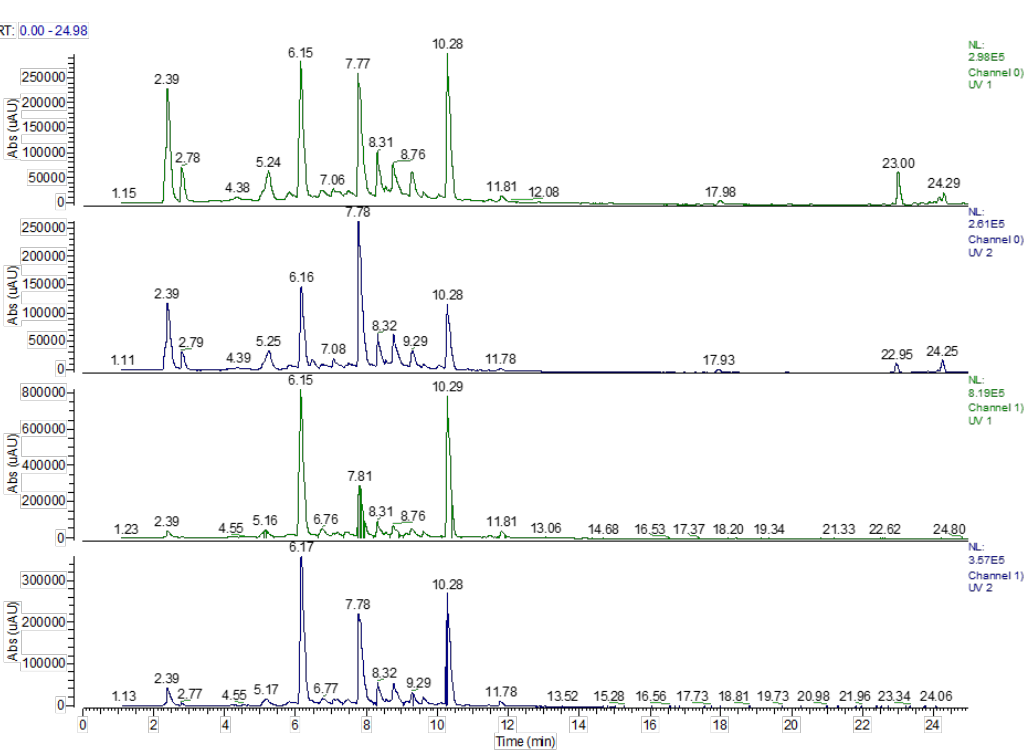
(C). Benzoic acid derivates (BA) and triterpenoid saponins (TT) were recognized in the samples. Other annotated groups of compounds were amino acids (AA), nucleotides (NA), carboxylic acids, some vitamins, and phytohormones.